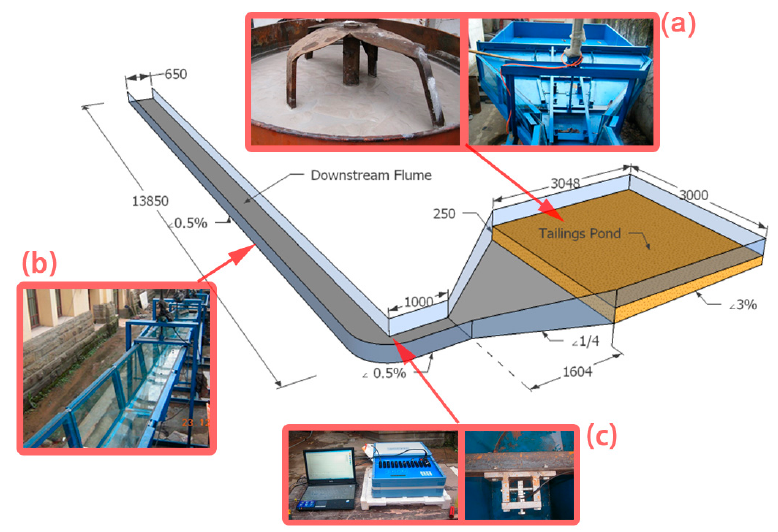
Figure 2. Experiment flume setup and dimensions (mm): ( a ) the slurry mixing device and storage tank; ( b ) the downstream flume; ( c ) the piezometer and data sampling system.